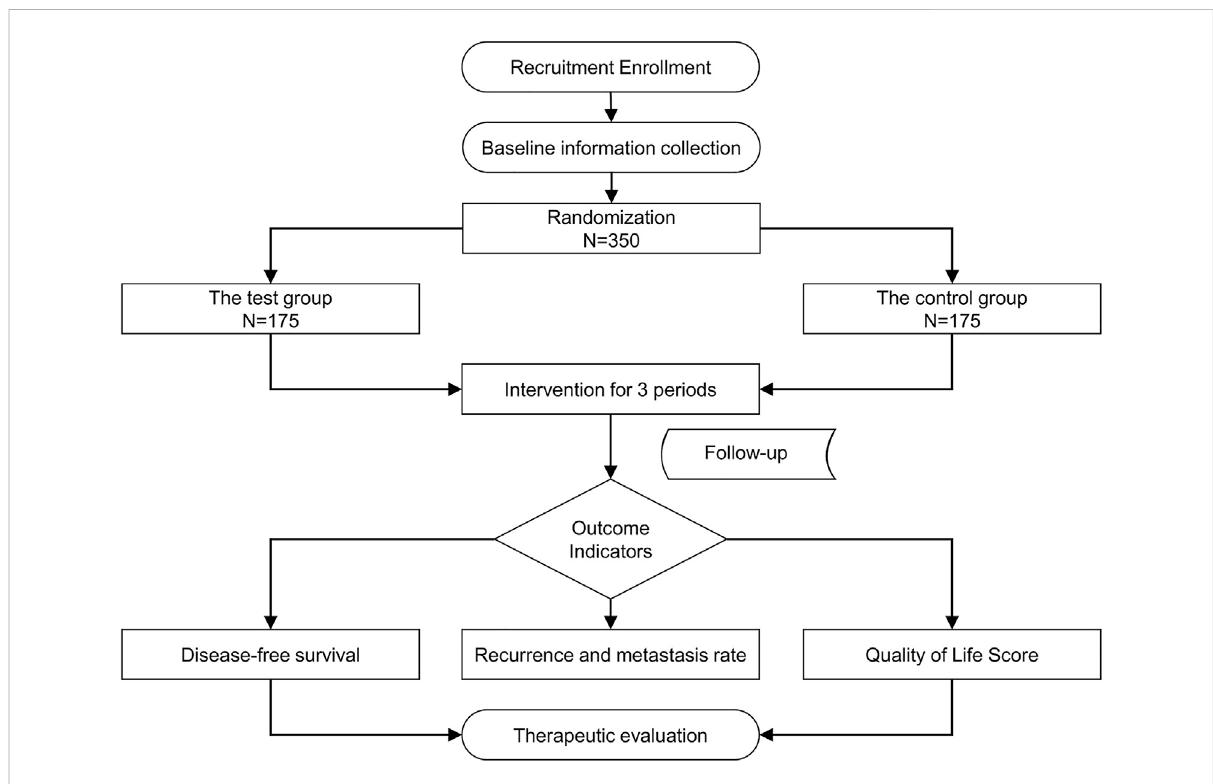
FIGURE 1 Flow chart of the study